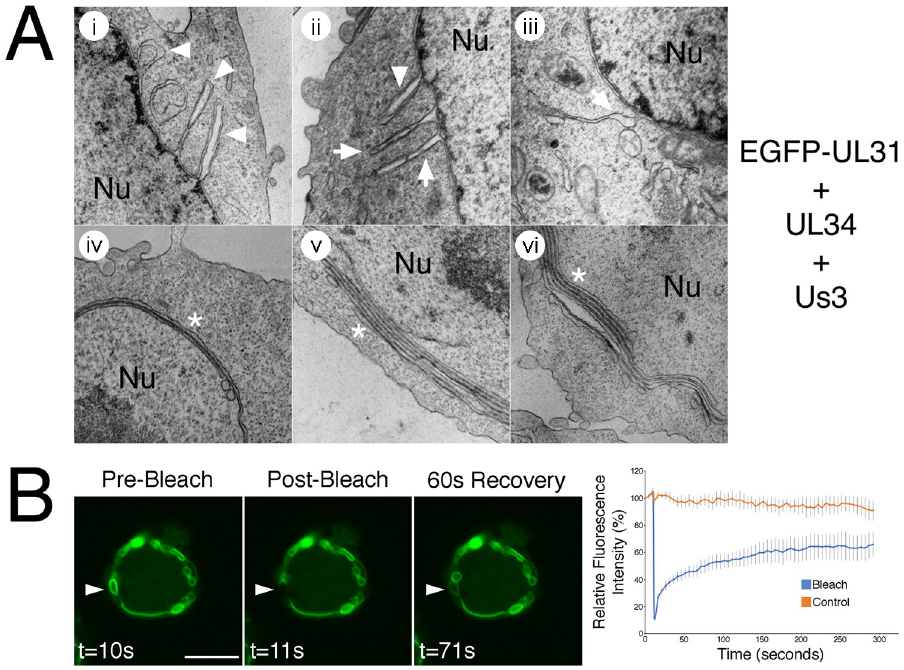
Fig 7. Characterization of extravagations formed in transfected HeLa cells. (A) Ultrastructural analysis. HeLa cells were co-transfected with plasmids encoding the indicated proteins. At 18 hours post transfection, cells were fixed and processed for TEM as described in Materials and Methods. HeLa cells co-transfected with plasmids encoding EGFP- pUL31, pUL34 and pUs3 formed extravagations that were not observed in control transfections receiving pCI-neo (see Fig 6). White arrowheads indicate extravagations comprised of both outer nuclear membrane (ONM) and inner nuclear membrane, white arrows indicate extravagations comprised of ONM only and white asterisks indicate zippered nuclear membranes, which were also not observed in control transfections. Nu indicates the nucleus. (B) Fluorescence recovery after photobleaching analysis. HeLa cells were co-transfected with EGFP-pUL31, pUL34 and pUs3. Live cells displaying extravagations were imaged at 18 hours post transfection and selected images of cells immediately before, immediately after, or at a later time after the region indicated by the arrowhead was photobleached are shown. Scale bar is 10 μ m. The corresponding quantification of fluorescence intensity over time of the photobleached region as well as a control region not subjected to photobleaching is shown beside the images. Error bars are standard error of the